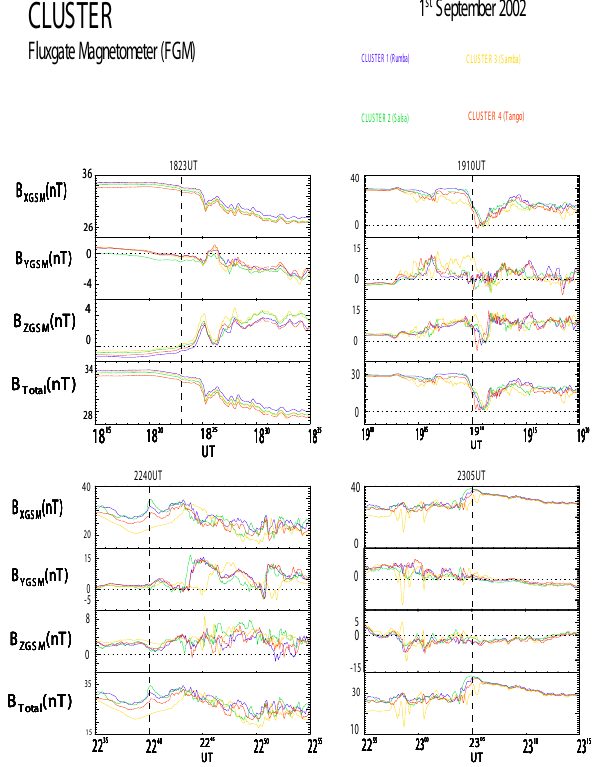
Fig. 12. Cluster FGM data for 1 September 2002 in the B x , B y , B z and B total GSM coordinates for intervals centred on 18:23, 19:10, 22:40 and 23:05 UT. Cluster 1 (Rumba) is shown in blue, Cluster 2 (Salsa) in green, Cluster 3 (Samba) in yellow and Cluster 4 (Tango) in